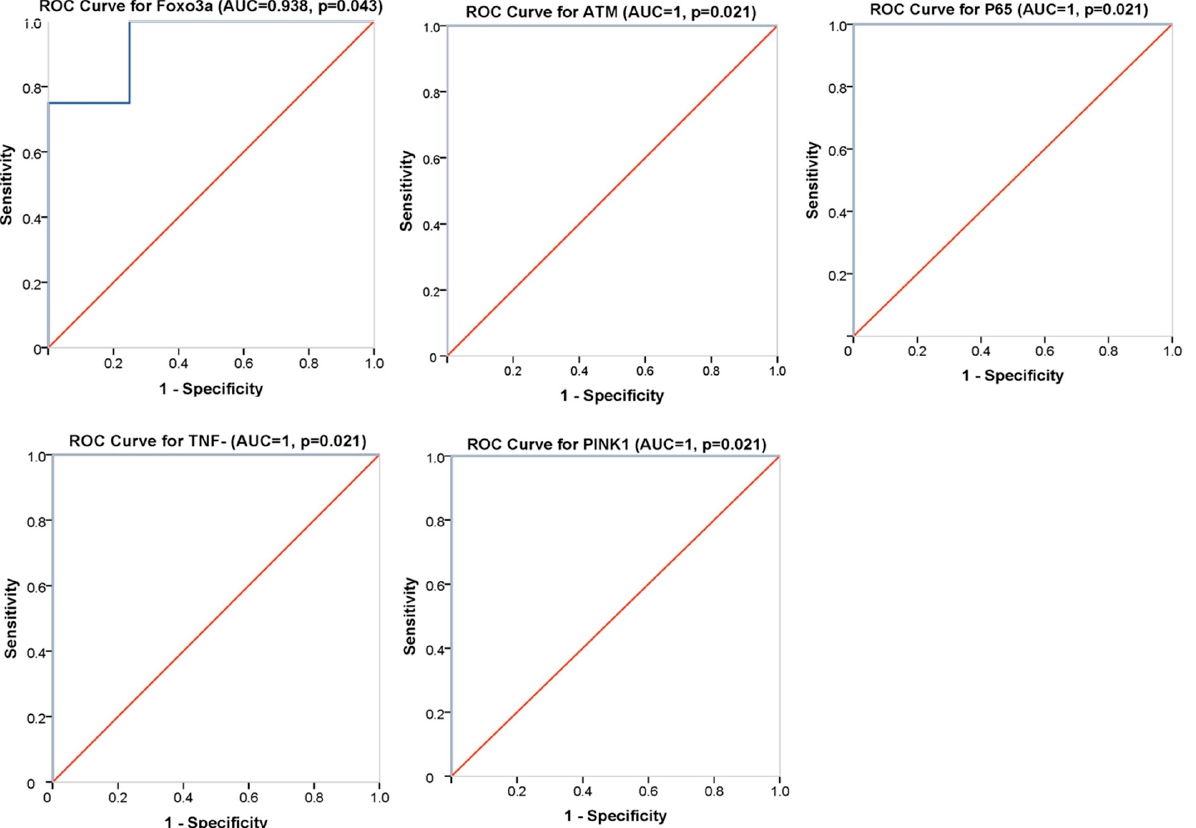
Figure 5. ROC curve analysis of differentially expressed genes between radio-induced and non-radio-induced BCC. ROC analysis for the FOXO3a , ATM , P65 , PINK1 and TNF- α genes in different plots. The p -value is the probability that the observed sample AUC-ROC is found when the true AUC-ROC is 0.5 (null hypothesis: the variable cannot distinguish between the two groups; area = 0.5 if the ROC coincides with the reference line). We found that the area under the curve is significantly different from 0.5. ATM , P65 , PINK1 and TNF- α have excellent discrimination performance, with AUCs = 1 (100%specificity and 100% sensitivity). The ROC curve foreach of them passes through the upper left corner of the plot, while FOXO3a has an ROC curve close to the upper left corner, with an AUC = 0.938 that represents an excellent diagnostic value.